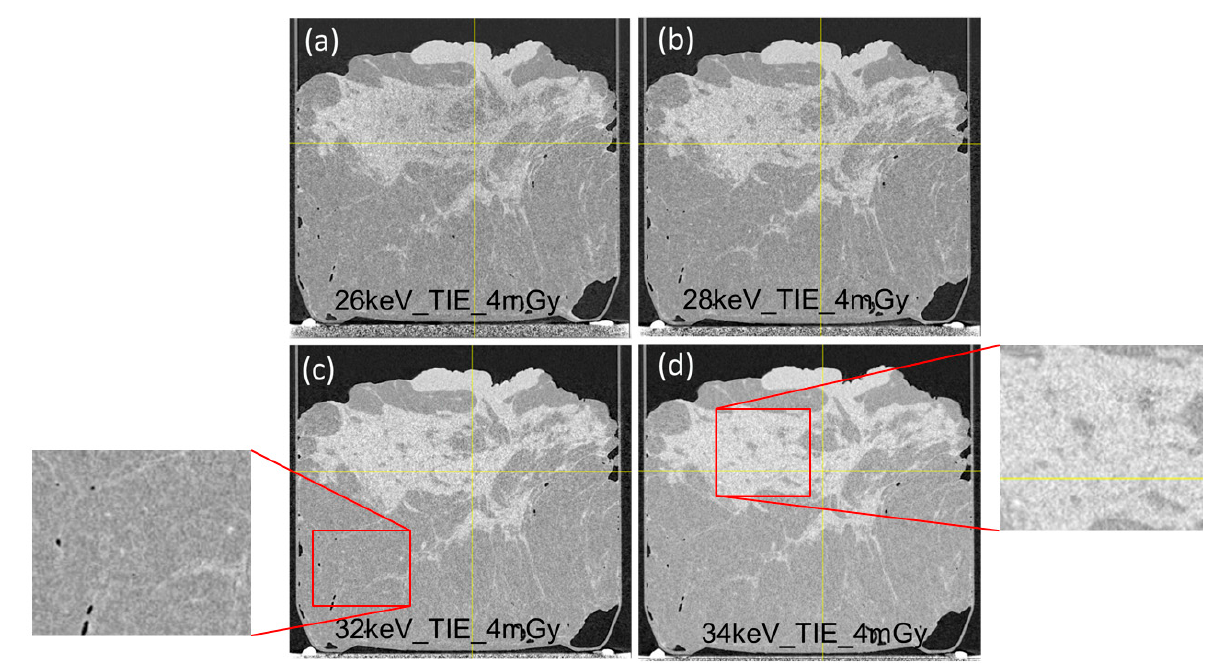
Figure 3. Comparison of PCT images of a breast tissue sample from a sagittal slice obtained using four different X-ray energies: ( a ) 26, ( b ) 28, ( c ) 32, and ( d ) 34 keV. For the dense glandular component (white color), the result from 34 keV shows the best quality, while 32 keV produces the best quality for the adipose component (gray color).